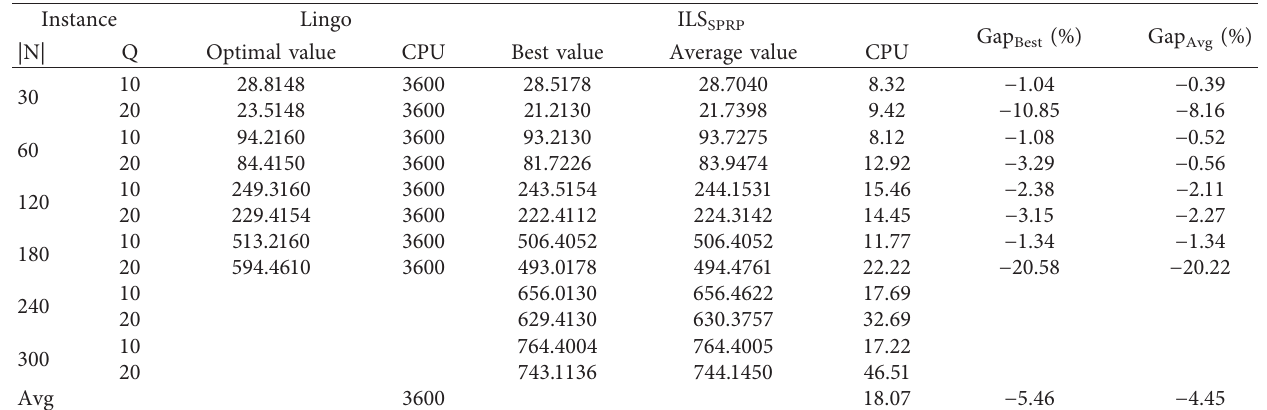
Table 4: Result comparison of Lingo and ILSSPRP ( T � 21600s).